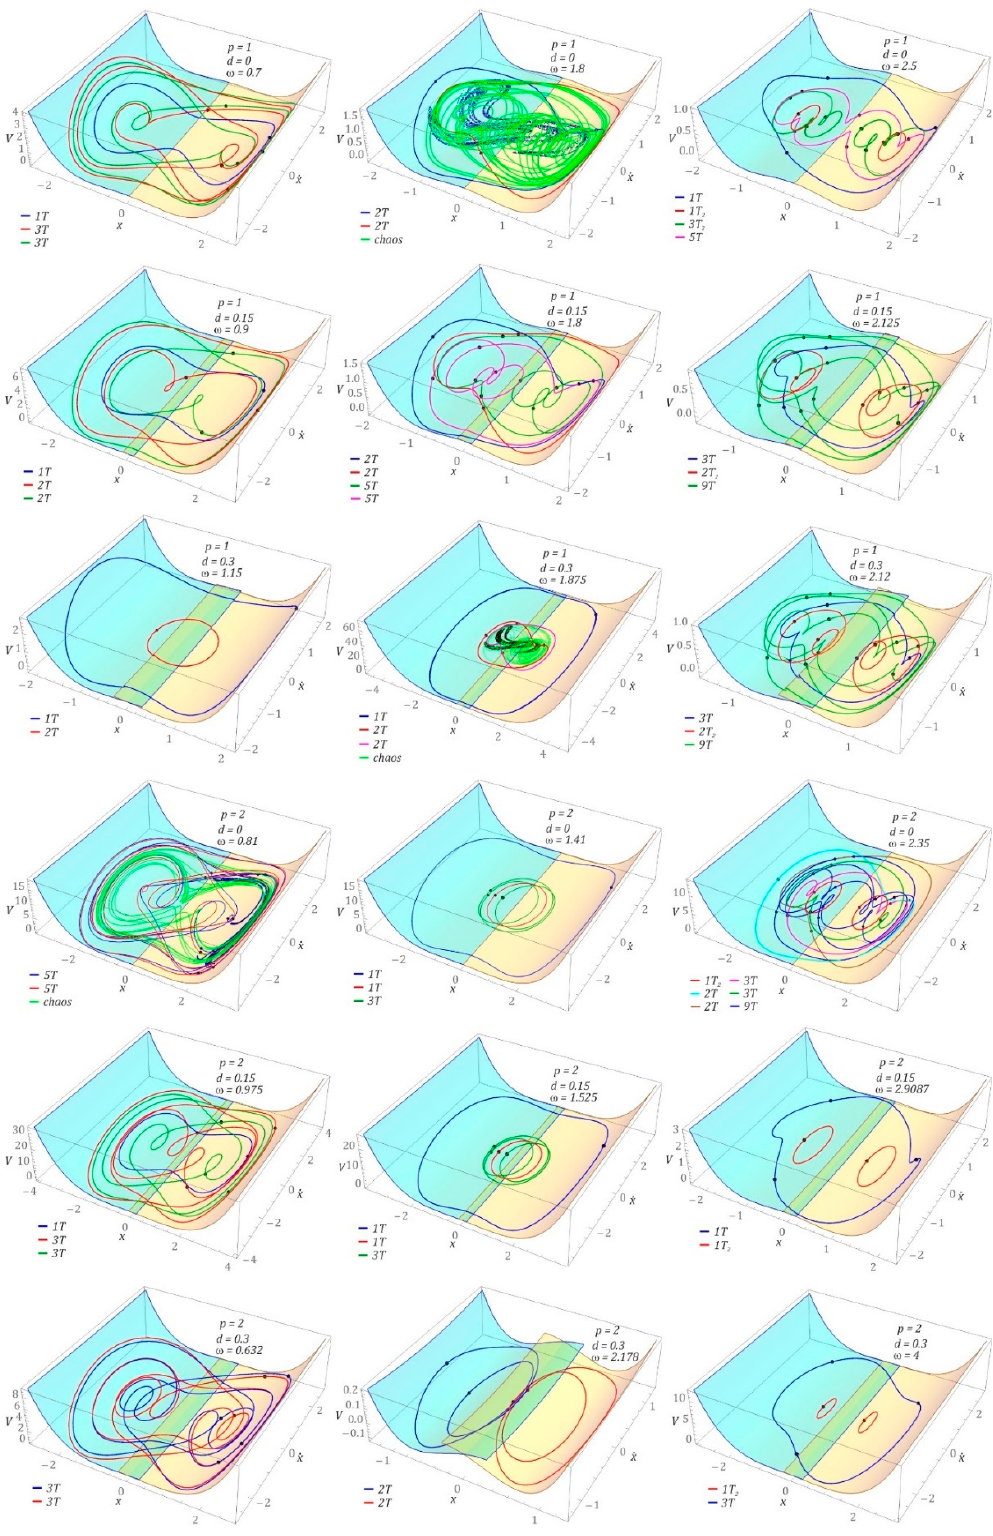
Figure 5. Influence of the parameters d and p on the efficiency of energy harvesting: 3D orbits with the vertical axis indicate the total mechanical energy. For clarity, the corresponding hysteretic potential is plotted with a division into two-color flaps with overlap. The system parameters are indicated in the figures.